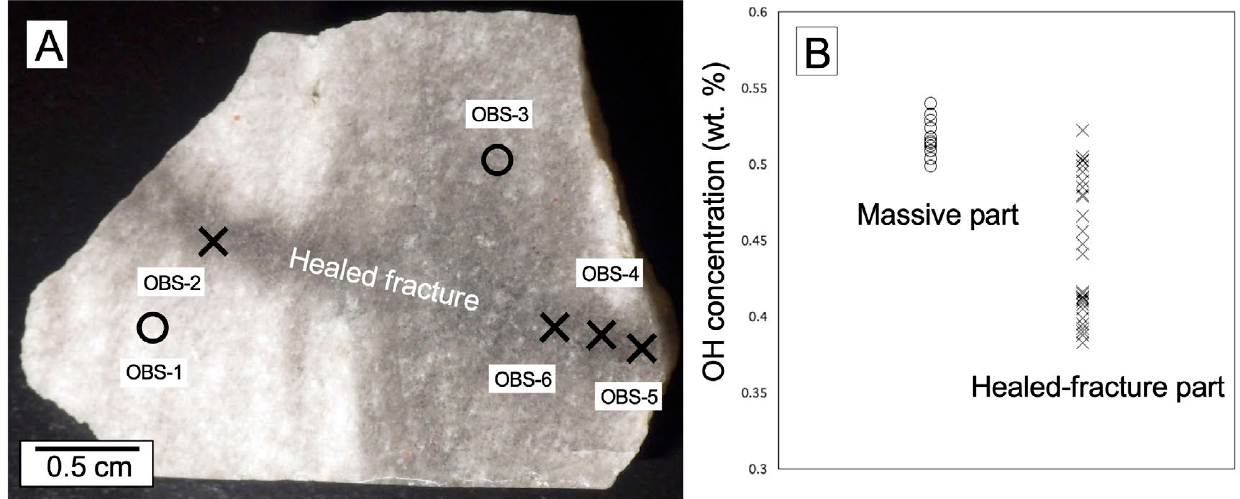
Figure 16: [A] Obsidian sample with the healed fracture for FTIR analyses. [B] Results of the FTIR analyses of the massive and healed fracture parts.